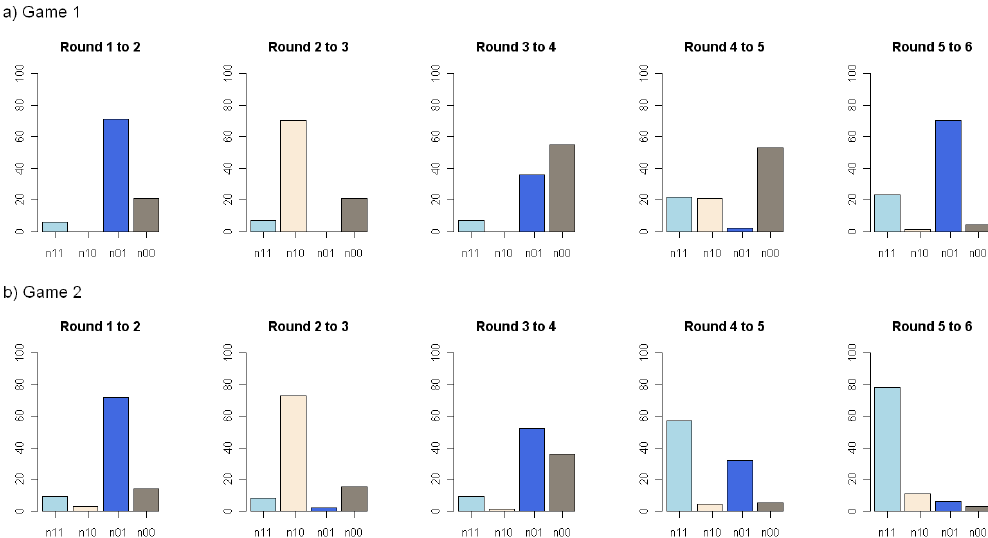
Fig. 5. Number of times a decision went from state i to state j ( n ij ) for Game 1 (top panel) and Game 2 (bottom panel) when moving from round k − 1 to the next round k . States can be either 1 (open the gate) or 0 (not open the gate). Flood occurred at rounds 5 and 6 during Game 1, and at rounds 1 and 5 during Game 2.